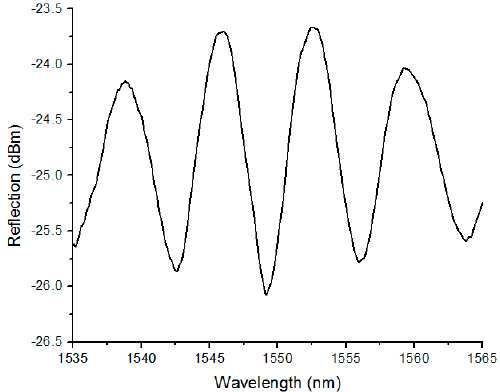
Figure 3. Measured reflection spectrum of the micro bubble sensor shown in Figure 2a.